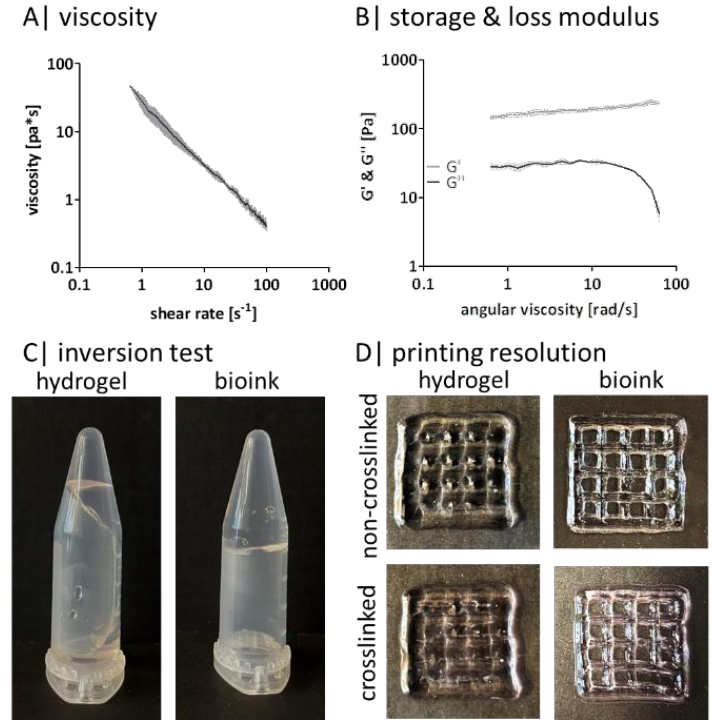
Figure 4. Gellan gum bioink characteristics: rheological measurement of ( A ) the viscosity and ( B ) of the storage and loss modulus with a rotational viscometer, n = 3; ( C ) representative image of an inversion test of (a) the hydrogel composition and (b) the bioink composition; ( D ) representative printing resolution with a 20 × 20 × 2 mm grid (20% infill, 410 µm nozzle) of left hydrogel composition and right bioink composition before (upper picture) and after crosslinking (lower picture).